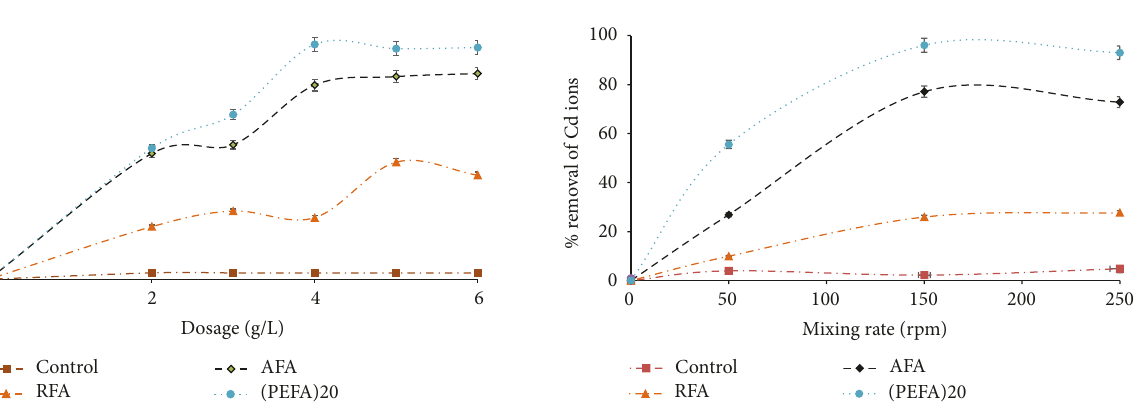
Figure11:TheinfluenceofAdsorbentdoseontheremovalefficiency of Cd (II) ions on FA based adsorbents (RFA, AFA, and PEFA) as a function of pH value of 9, 2mg/L metal ion concentration, 15 min contact time, mixing rate of 150 rpm, 50 mL volume of aqueous solution, and 298 K temperature.